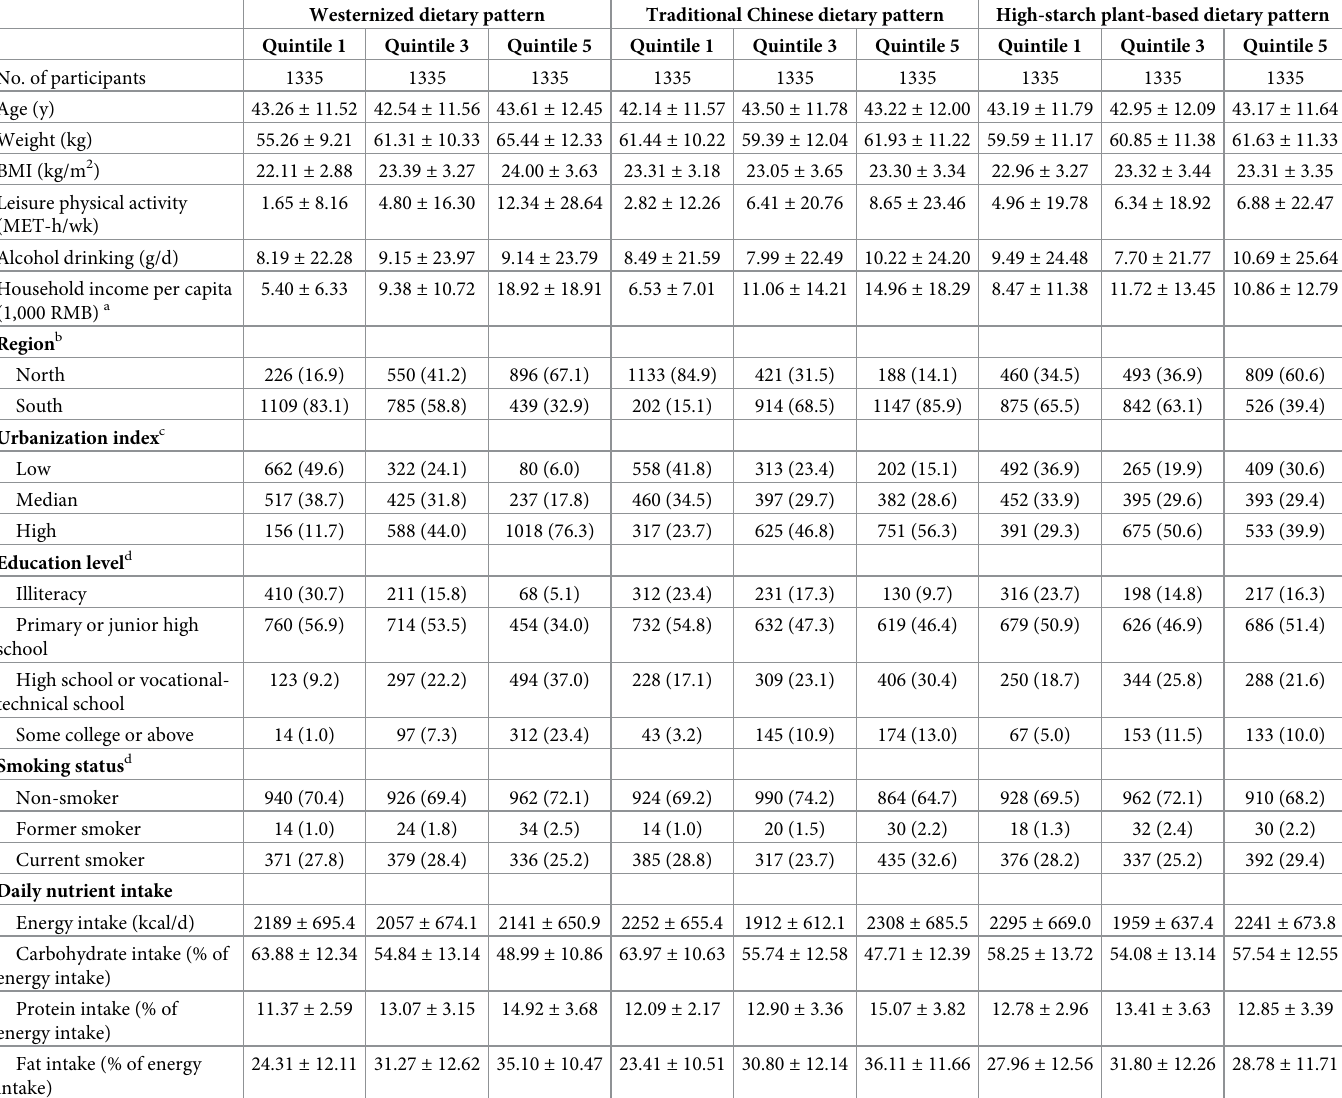
Table 2. Baseline characteristics according to quintiles of dietary patterns in men and women